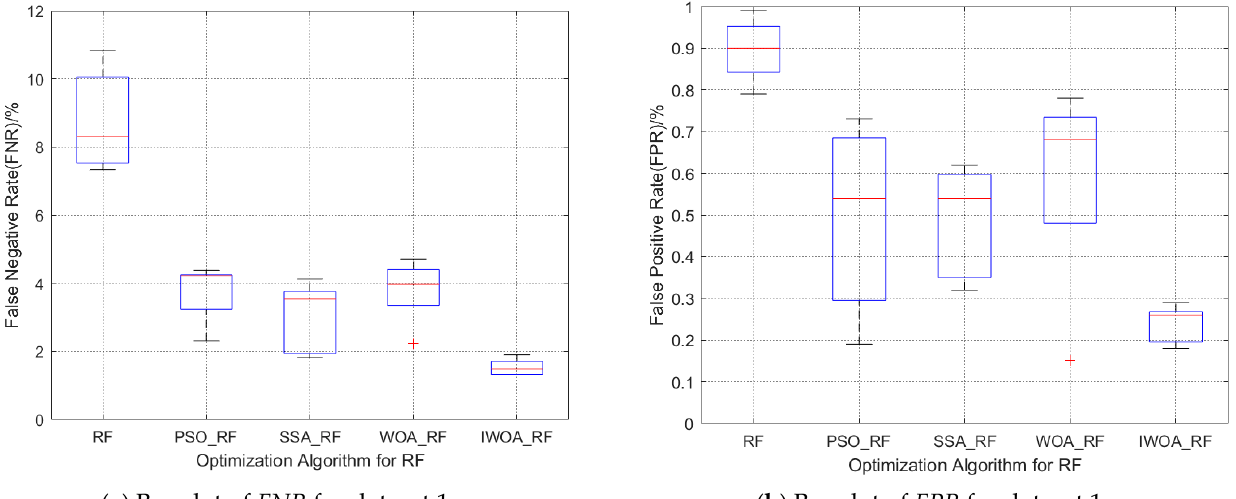
Figure 5. Boxplot of FNR and FPR for dataset 1.